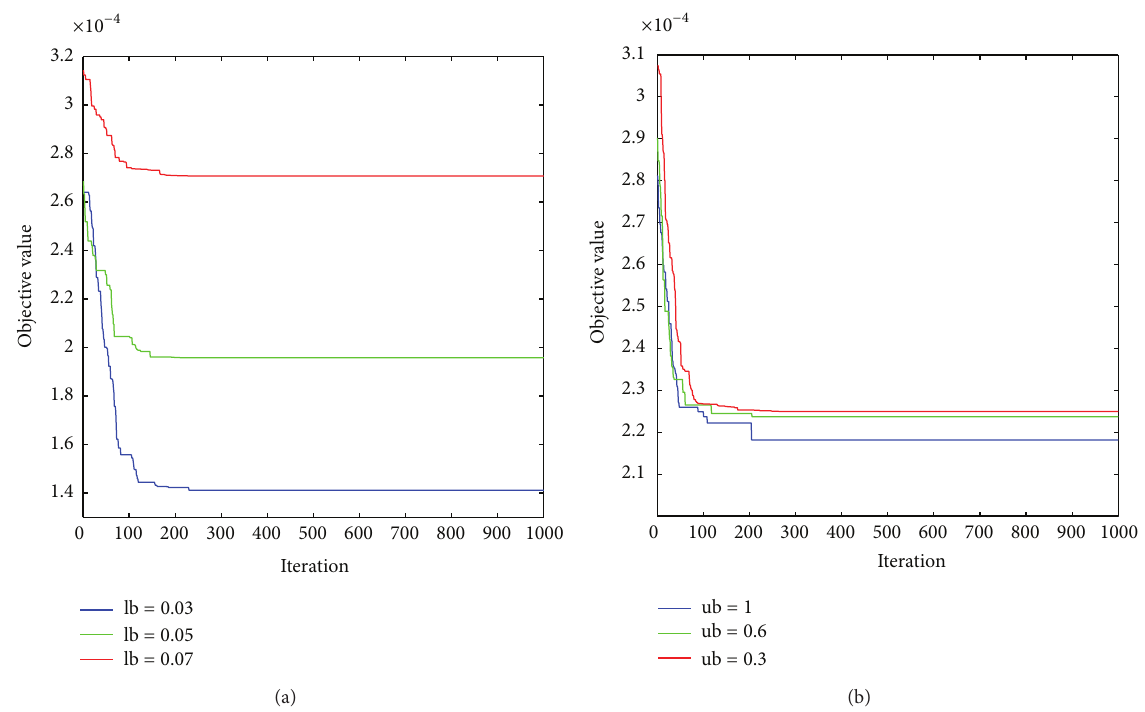
Figure 2: The performance of the ABC algorithm under different bound constraints.